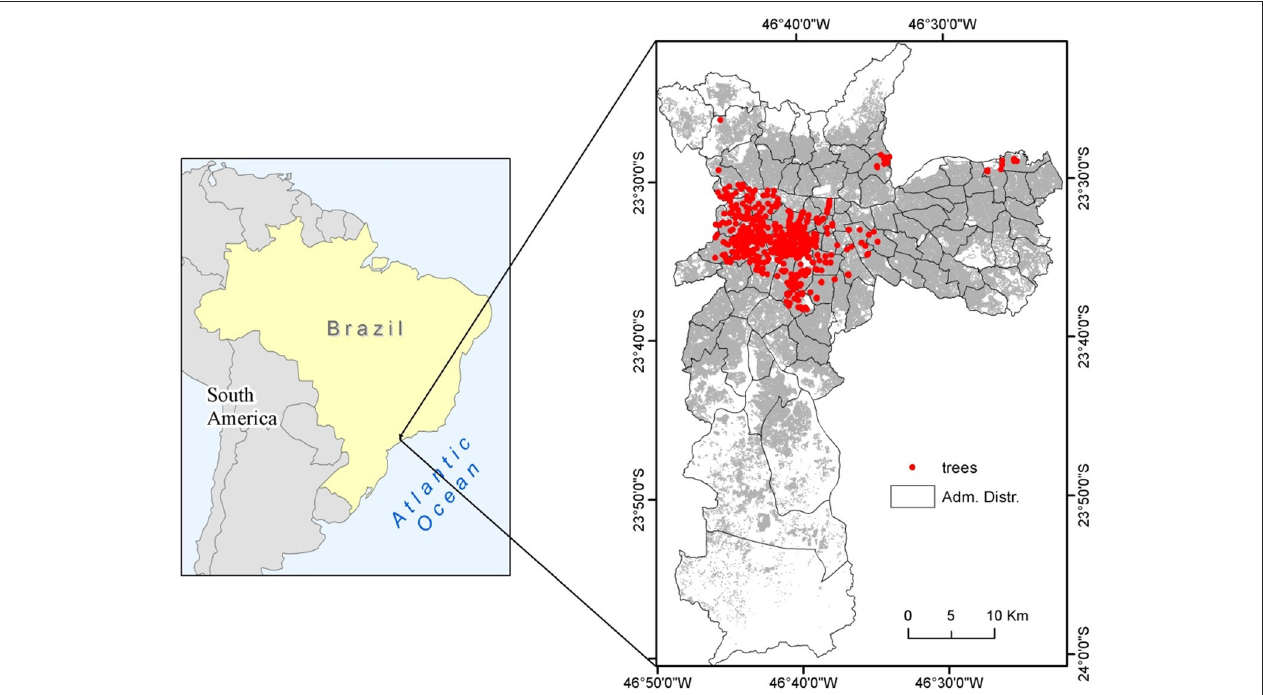
FIGURE 1 | Location of all sampled trees and districts in the study area (São Paulo, Brazil).